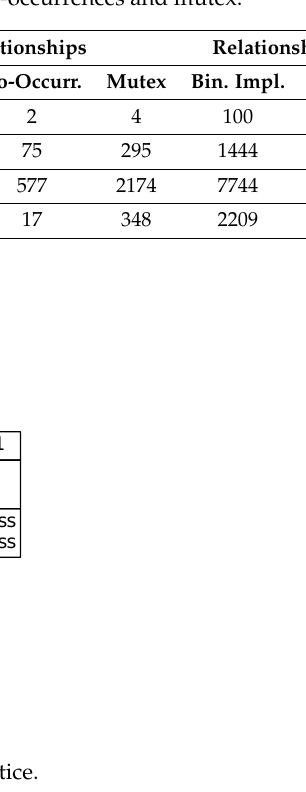
Table 10. Metrics on the binary implications, co-occurrences and mutex.